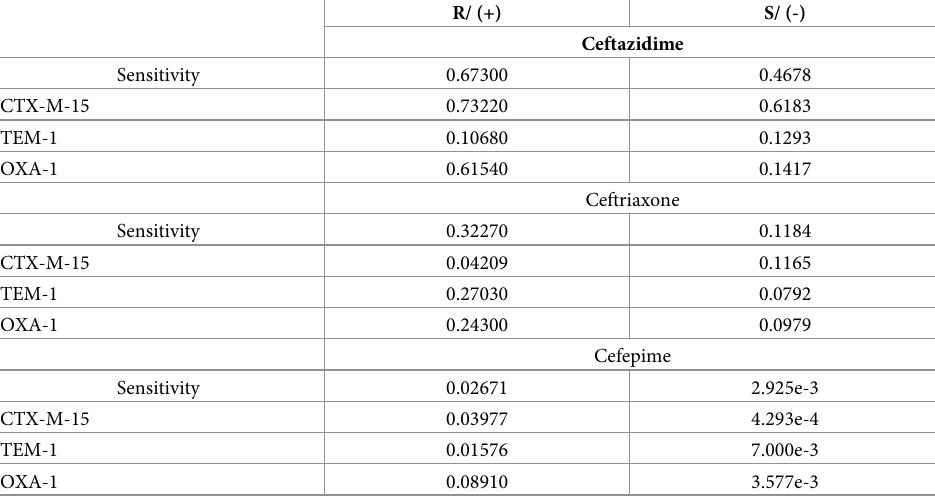
Table 1. P-values for Shapiro-Wilk normality test in each condition. For the row labeled “Sensitivity”, the first col- umn corresponds to resistance to the antibiotic (R), and the second column corresponds to susceptibility to the antibi- otic (S). For the rows labeled with a resistance gene (CTX-M-15, TEM-1, OXA-1) the first column indicates the presence of a resistance gene (+), while the second column indicates the gene is not present (-). All cases except growth rates in the presence of cefepime in the second column (-/S) indicate normality (with p < 0.01).